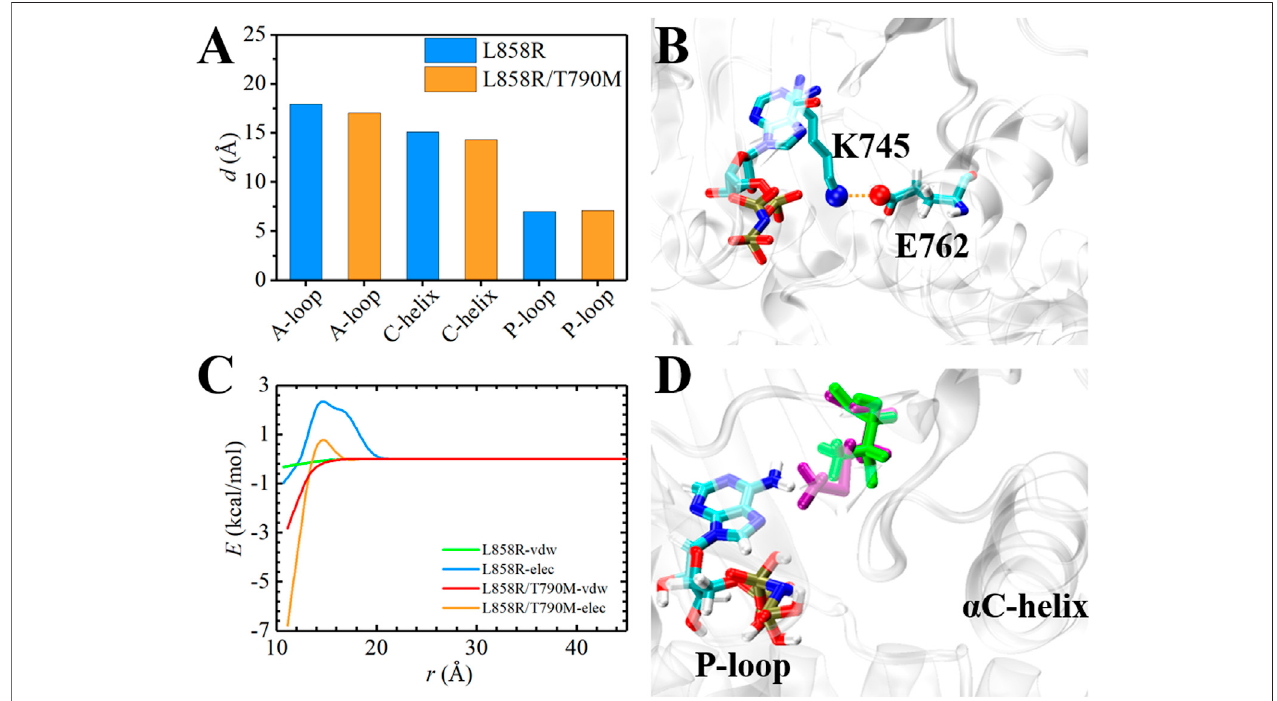
FIGURE4| StructuralanalysisofEGFRmutantsandAMP. (A) Time-evolutionoftheaveragedistancebetweenA-loop, α C-helixandP-loopandAMP,respectively. (B) The interaction of E762 and K745 in L858R/T790M mutant. (C) The pair interaction energy for the separation between the ligand and α C-helix ofthe EGFR mutants. (D) Superposition and comparison between the structures of Thr790-AMP pair and mutant Met790-AMP pair. Thr790 and Met790 are colored in green and purple,